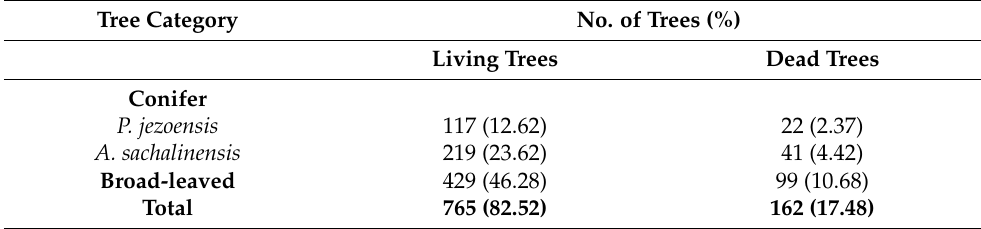
Table 3. Summary of the living and dead trees of major conifer species, broad-leaved trees, and all the trees in period